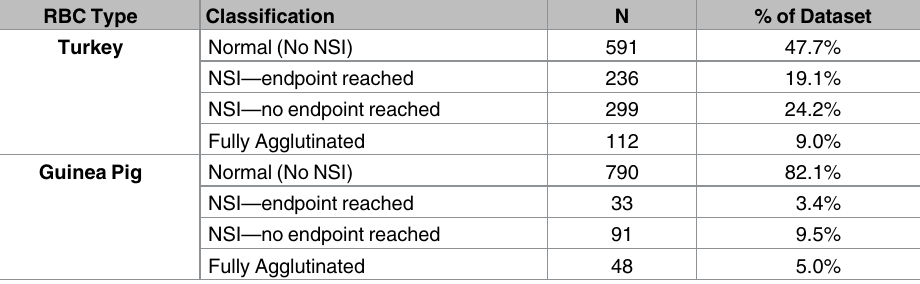
Table 1. Sample classifications based on morphological